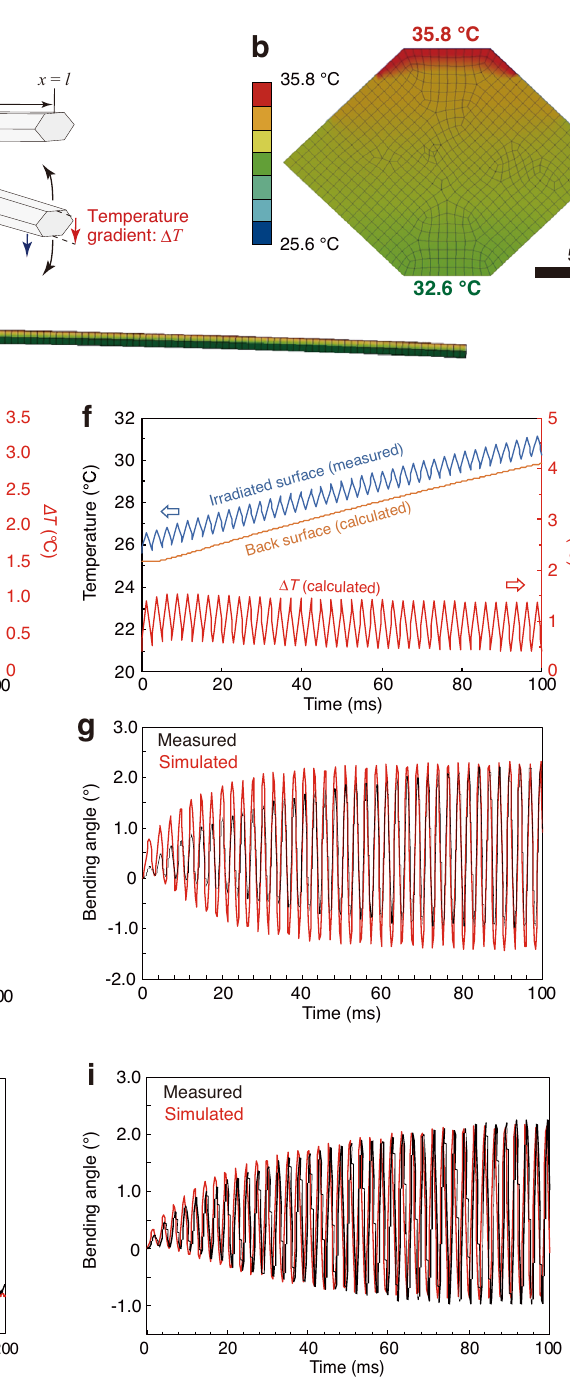
irradiationfor100ms.Theinsetvaluesof τ on and τ off indicatethetimeconstantsfor bendingandstraightening. f Timedependenceof thetopsurface(blue,measured) andbacksurface(orange,calculated)temperaturesandthetemperaturedifference betweenthetwosurfaces( Δ T ,red,calculated)under390Hzpulsed UVirradiation. g Time pro fi les of measured (black) and simulated (red) bending angles, ampli fi ed under 390Hz pulsed UV irradiation. B Simulation II based on the irradiated light energy. h Time pro fi les of measured (black) and simulated (red) bending angles withandwithoutUVlightirradiationfor100ms. i Timepro fi lesofmeasured(black) and simulated(red)bending angles, ampli fi ed under 390HzpulsedUV